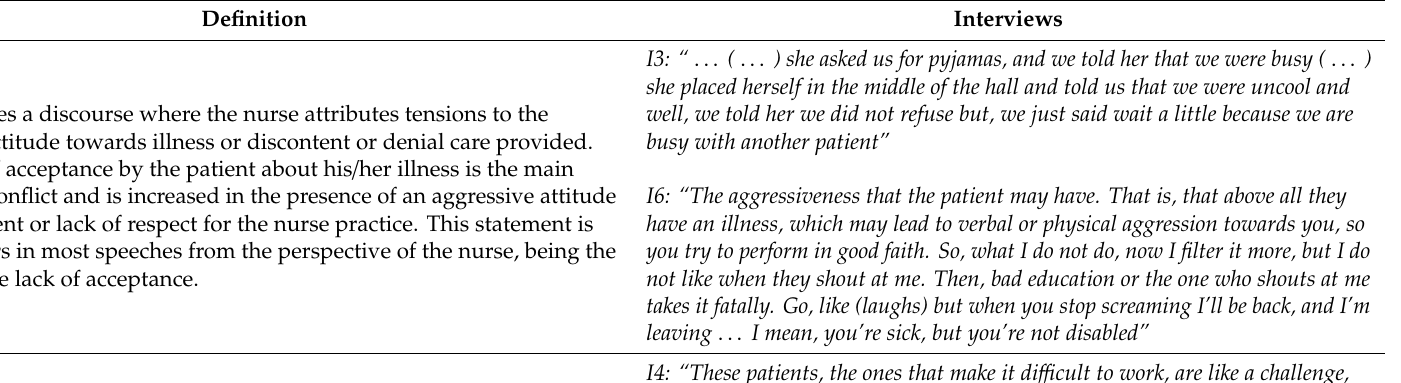
Category: Patient as a Passive Object of